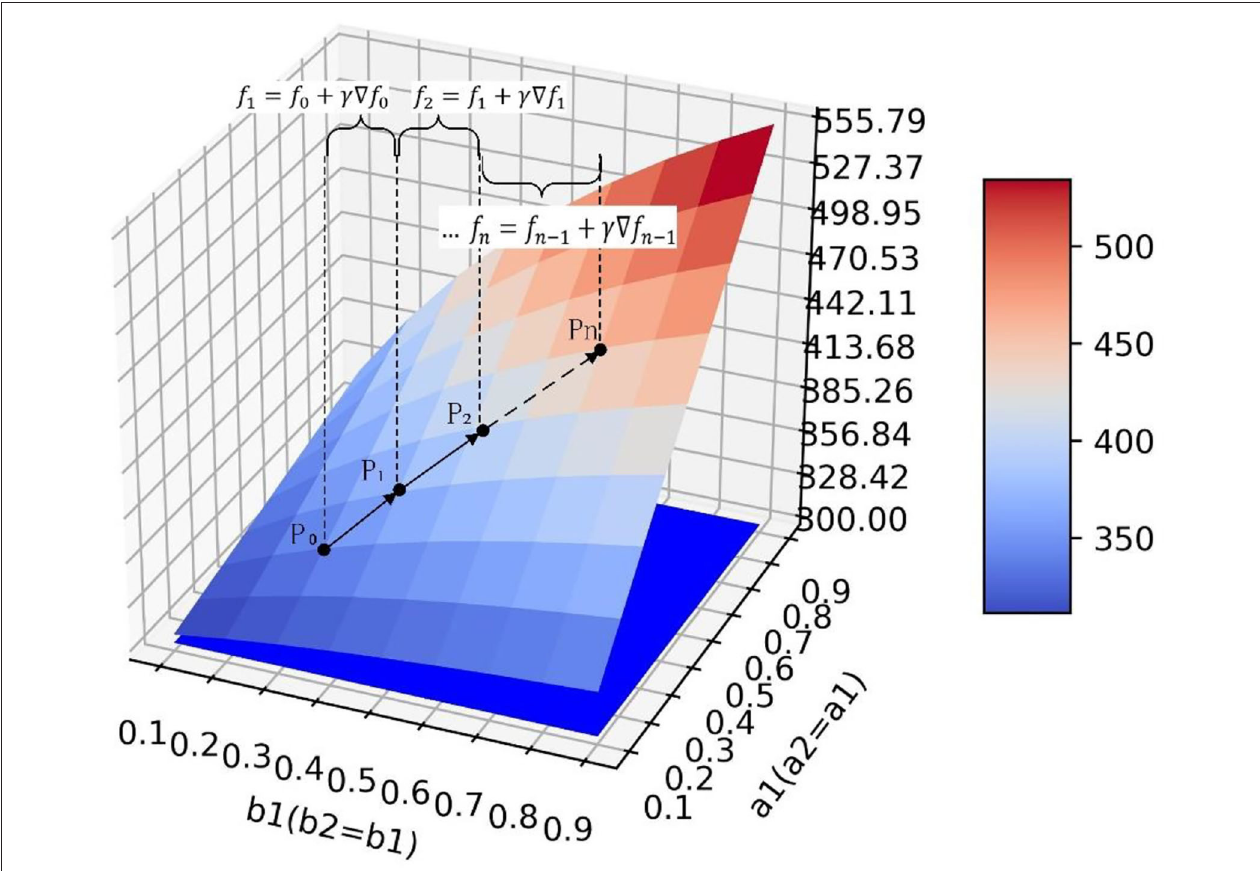
FIGURE 13 | The optimal policy path on the